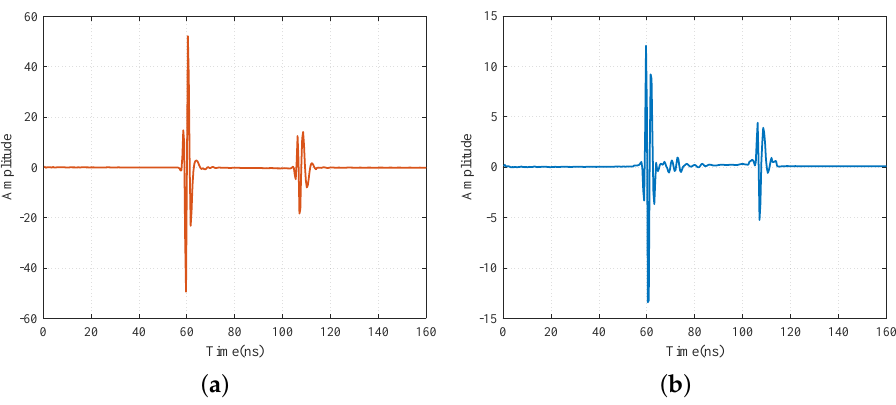
Figure 10. The 75th trace of profiles. ( a ) HH polarization mode. ( b ) HV polarization mode. Add 10 dBw Gaussian noise to the simulated data, then decompose and reconstruct it using the WOA-VMD-BD method. After adding noise, the layered interface details are covered. The simulated profiles in HH and HV polarization modes and the corresponding data of the 75th track are shown in Figures 11 and 12.